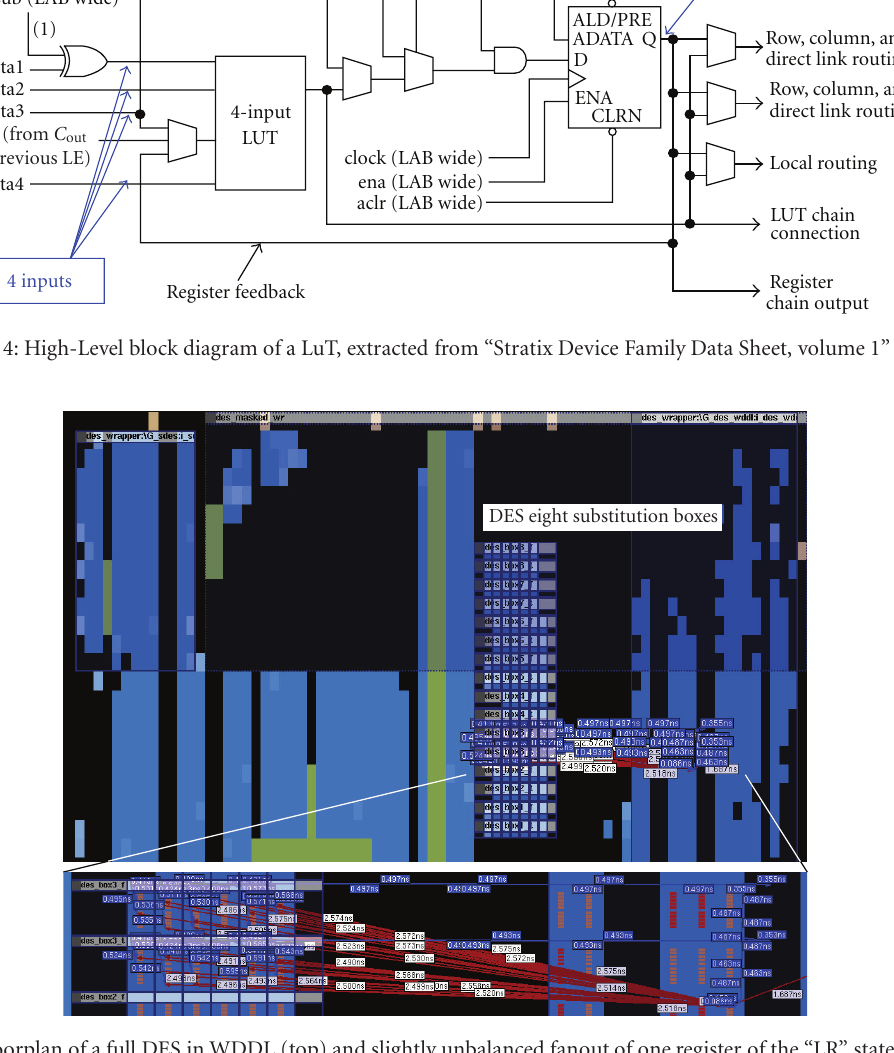
dual wires: for example, the bit of R M on the top has an imbalance of 289 − 290 = −